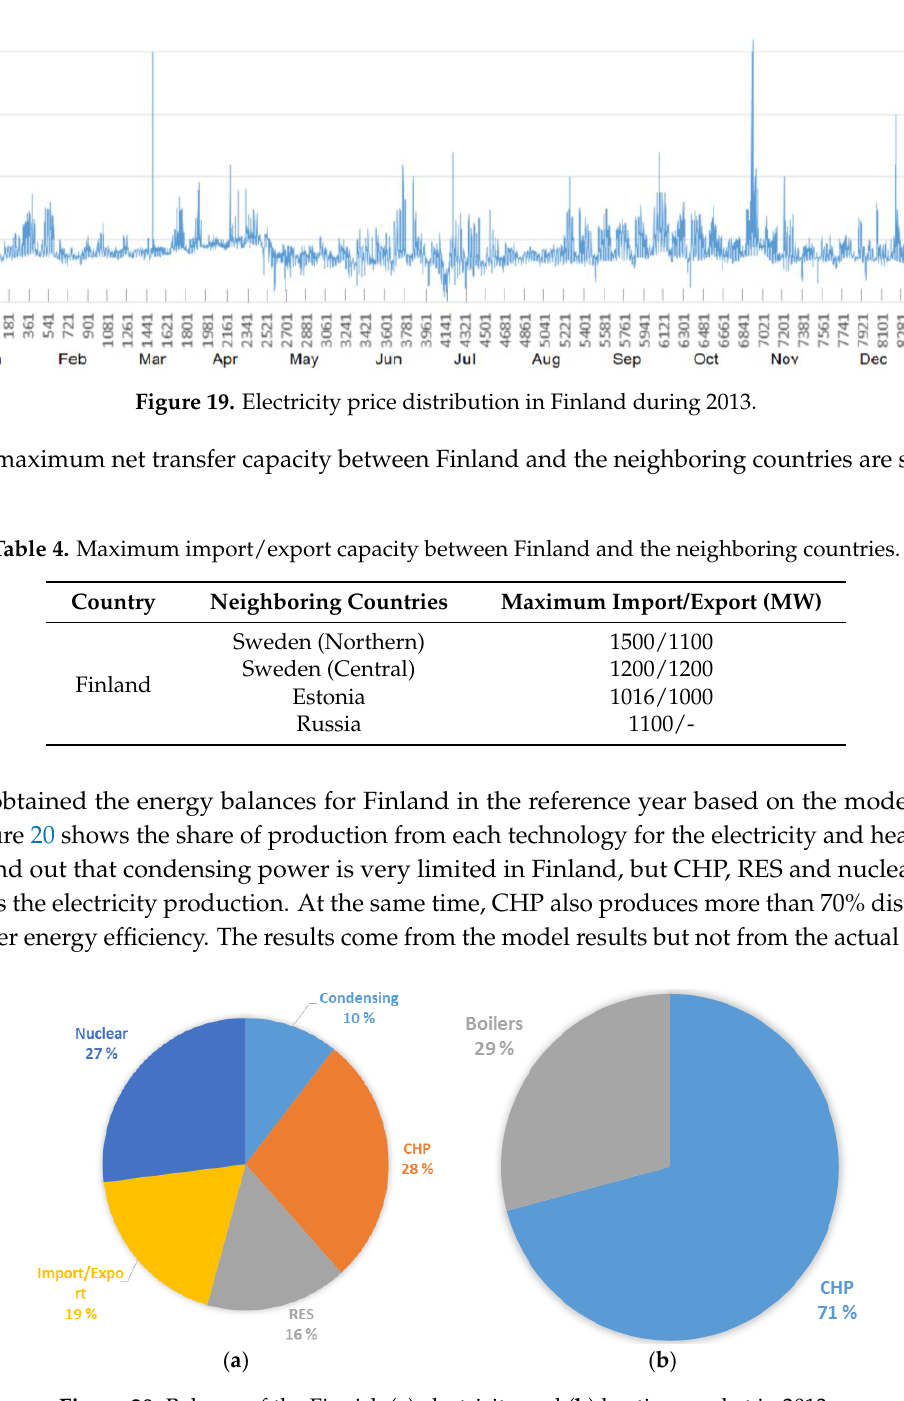
Figure 20. Balance of the Finnish ( a ) electricity and ( b ) heating market in 2013.